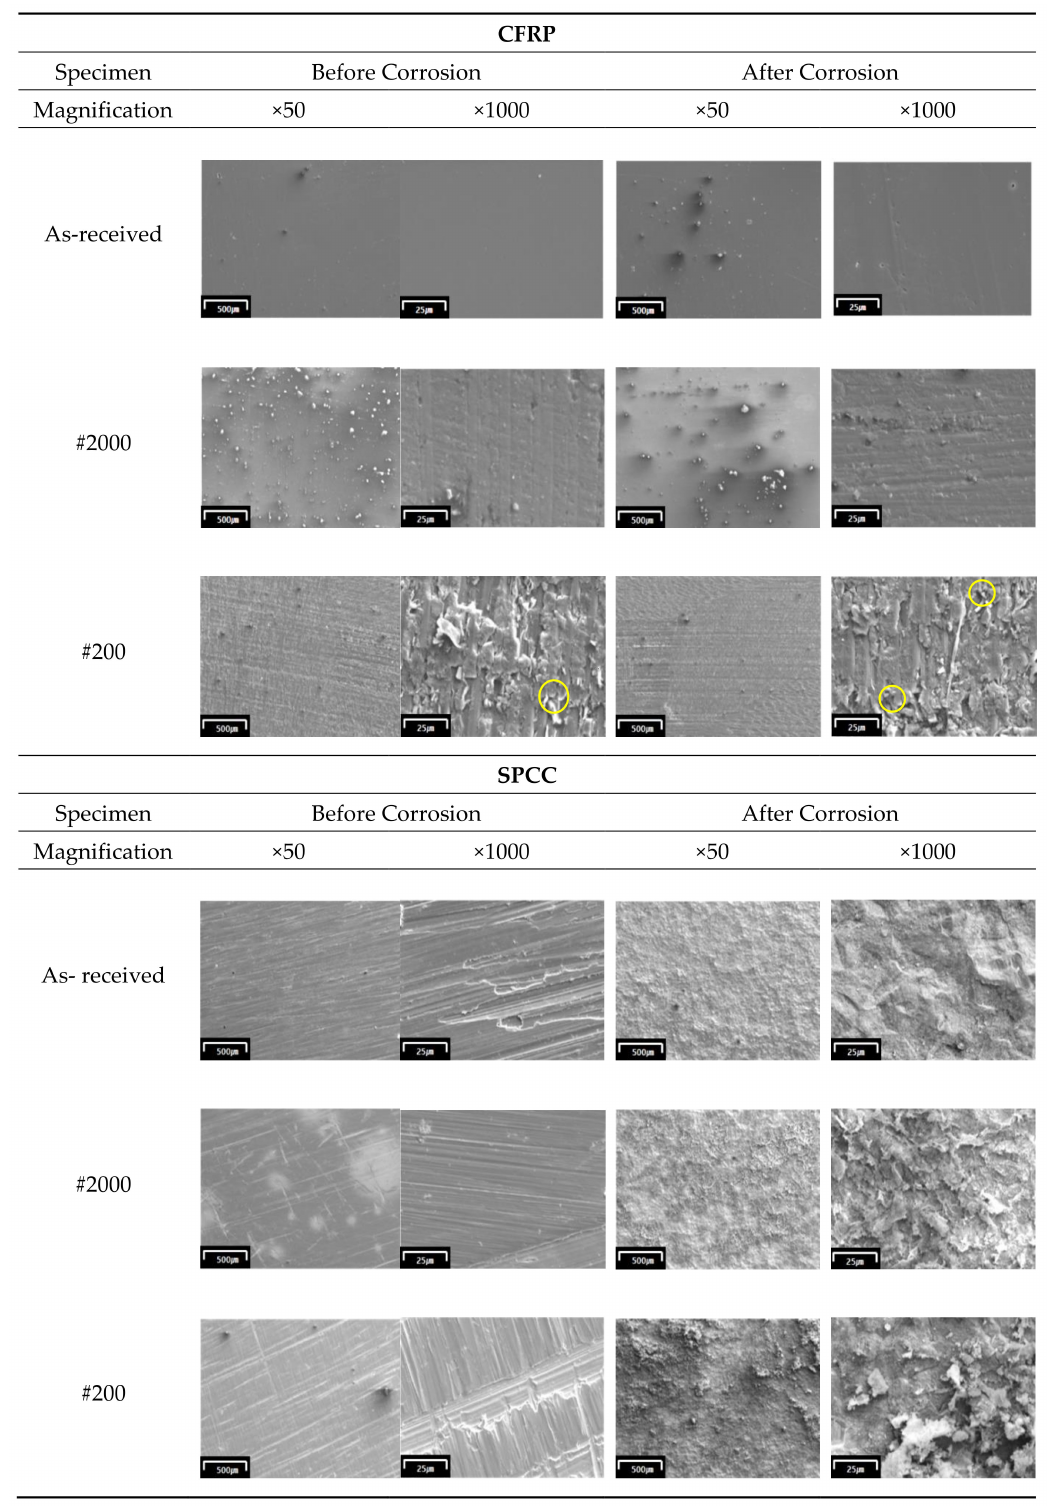
Figure 4. Microstructure of CFRP and SPCC, before and after corrosion